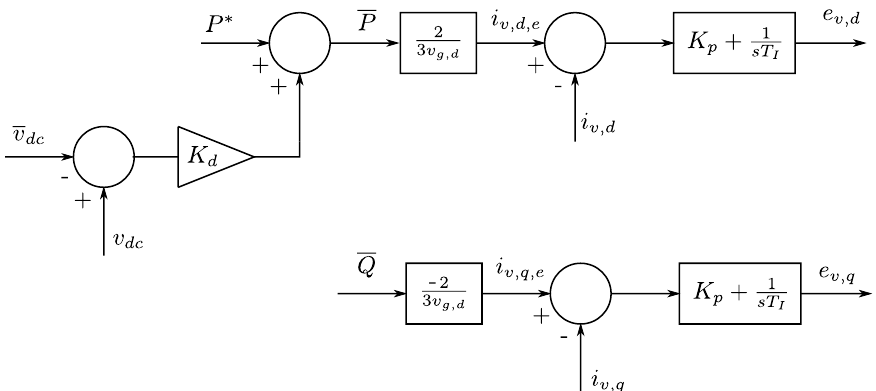
Figure 8. Output current controller of a droop controlled terminal.